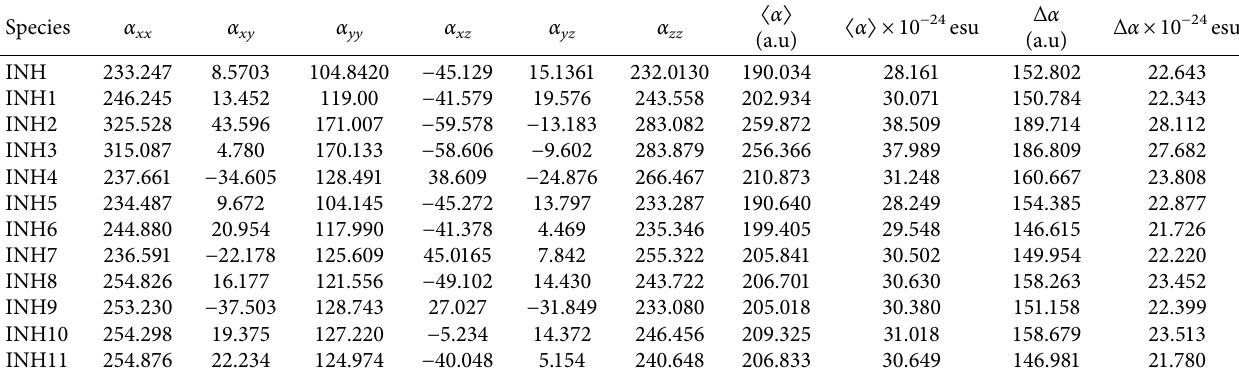
Table 6: Static average polarizabilities of the studied compounds, calculated at ω � 0 at the B3LYP-D/6-311G (d, p) level of theory in the gaseous